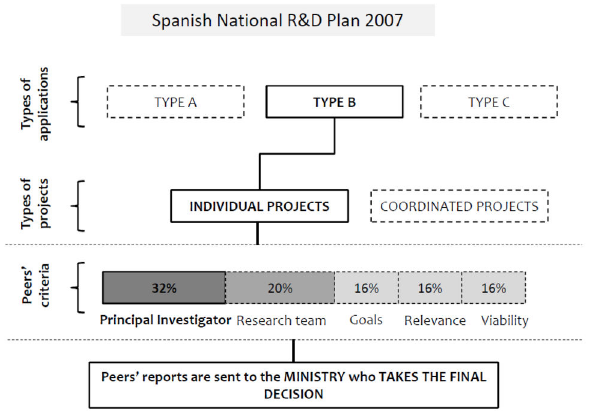
Figure 1. Flowchart of the evaluation process of